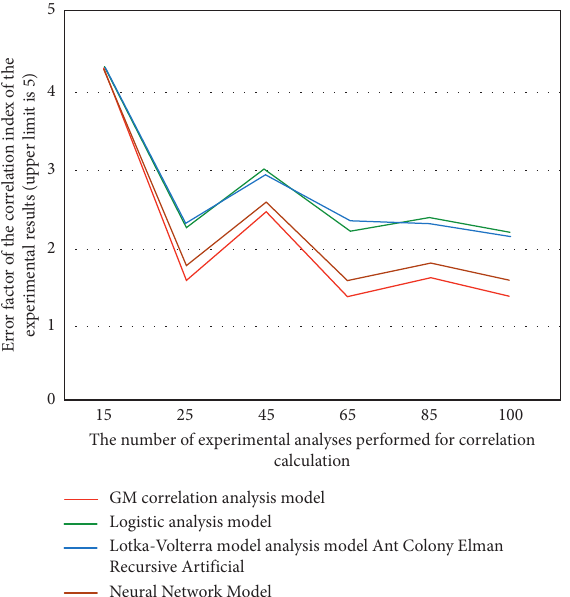
Figure 7: Error factors of the correlation index obtained under four different correlation analysis algorithms.